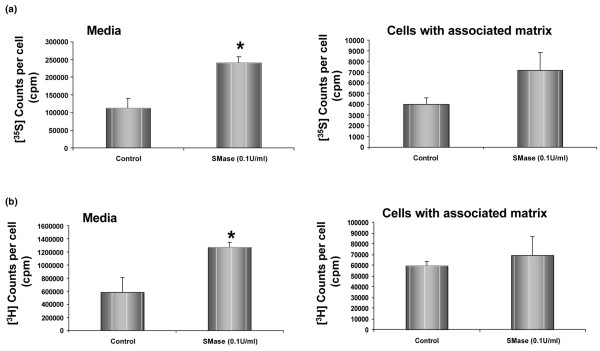
Sphingomyelinase increases de novo sGAG and collagen synthesis in articular chondrocytes. Bovine articular chondrocytes were cultured for 7 days with 20 μCi/ml [3H]-proline and 10 μCi/ml [35S]-sulphate in the presence or absence of SMase (0.1 U/ml). At the end of the culture period, unincorporated label was removed and (a) [35S] counts (cpm) were measured in cell associated material and media as a measure of de novo sGAG. De novo collagen synthesis was determined by digesting labelled protein in media and cell extracts with 8U bacterial collagenase overnight at 37°C. Digested collagen fragments were removed using Ultrafree®-MC filter units and remaining [3H] counts taken as a measure of noncollagenous protein. (b) Collagenous protein was calculated using the following equation: collagen (cpm) = total protein ([3H] counts before collagenase digestion) – noncollagenous protein (counts remaining after collagenase digestion). Data are normalized to cell number and presented as mean ± standard error. * P < 0.05 versus control. cpm, counts/min; sGAG, sulphated glycosaminoglycan.